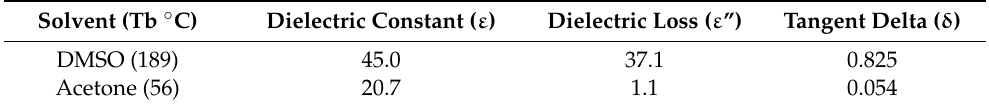
Table 2. Dielectric constant ( ε ), tan δ , and dielectric loss ( ε ”) for DMSO and acetone (measured at room temperature and 2450 MHz) [53].